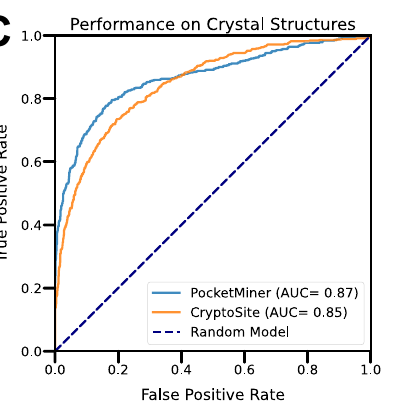
Fig. 5 | The PocketMiner graph neural network accurately detects sites of cryptic pocket formation in experimental structures. A PocketMiner predicts a highlikelihoodofcrypticpocketformationatthesiteofligandbinding.Theligand (cyan) from the aligned holo structure is shown on the apo structure to highlight the steric clash between the ligand and a loop that must move to create the holo binding site. Though PocketMiner only uses the apo structure to generate a pre- diction (blue indicates low probabilities of cryptic pocket formation while red indicates high probabilities), the predicted labels are also shown on the holo